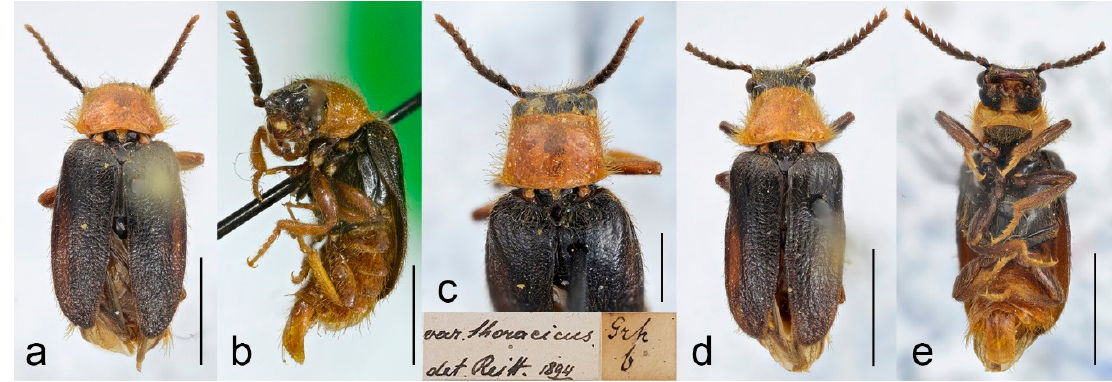
Figure 15. Malacogaster passerinii Bassi, 1834. Male lectotype of Malacogaster passerinii var. thoracicus Redtenbacher, 1858 ( a ) Habitus, dorsal view; ( b ) habitus, lateral view; ( c ) pronotum and basal portion of elytra, dorsal view. Specimen from Sicily (NHMW). ( d ) Habitus, dorsal view; ( e ) habitus, ventral view. Scale bars = ( a , b , d , e ) 3.0 mm; ( c ) 1.5 mm. Photographs courtesy of H. Schillhammer and M. Seidel (NHMW).